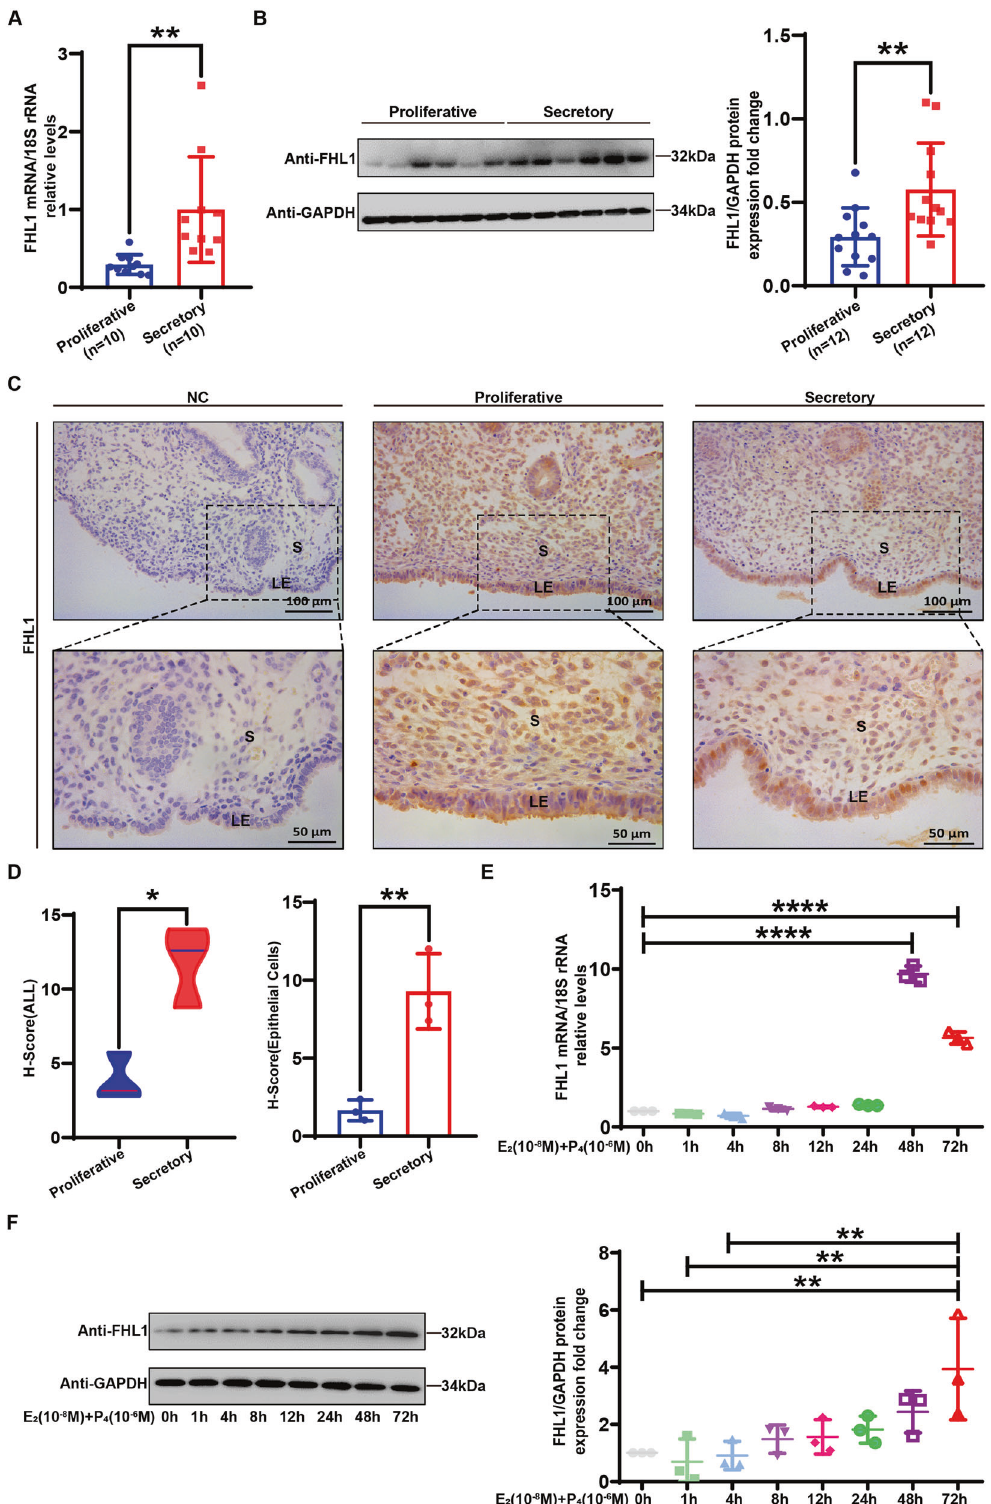
FHL1 expression was knocked down in the uteri of mice (Fig. 3D, E). At the same time, the number of unplanted embryos increased signi fi cantly in the siFHL1 group, suggesting that interference with FHL1 expression inhibits blastocyst-epithelial